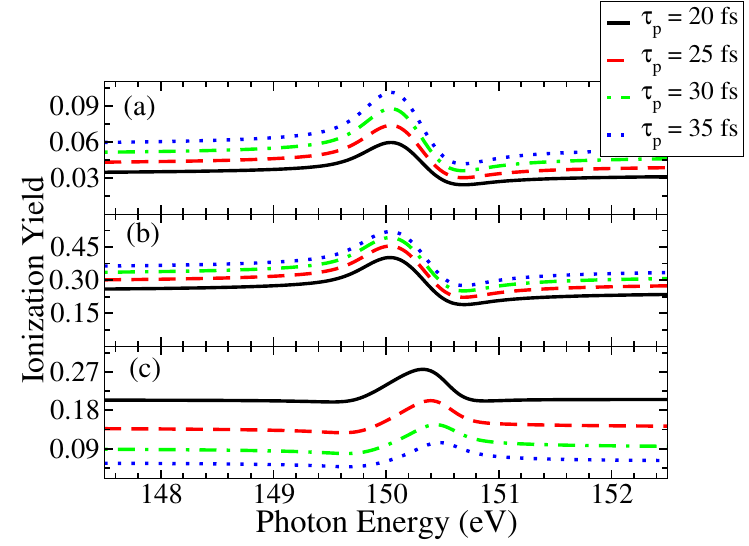
Figure 4. Effect of pulse duration on the ionization yield is shown in this plot. The coherence time used is τ c = 3 fs (124.02 a.u.) and the peak intensities are: 10 13 W/cm 2 for ( a ), 10 14 W/cm 2 for ( b ) and 10 15 W/cm 2 for ( c ). For lower intensities, as pulse duration increases, the ionization yield also increases. But the pattern flips after certain peak intensity and for the highest peak intensity of 10 15 W/cm 2 , the yield drops as pulse duration increases.